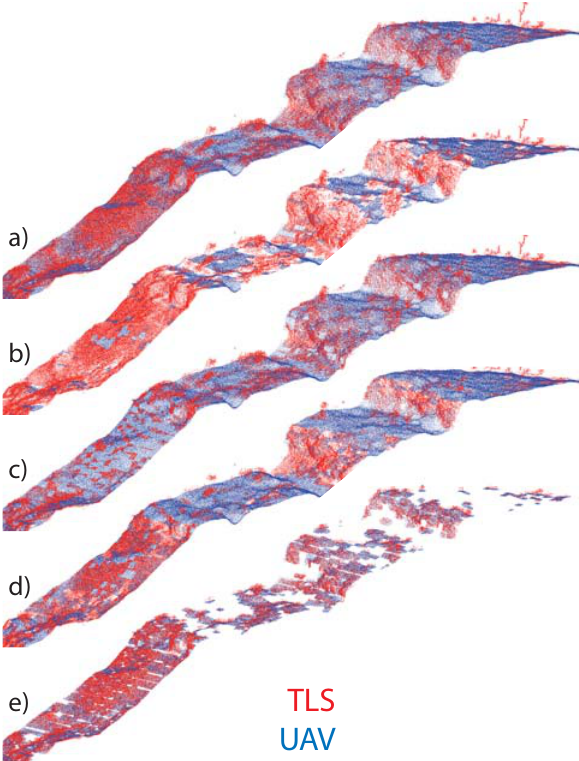
Figure 11. Point cloud profile of the data acquired in 2016 (3m wide; location indicated in Fig. 9) showing examples of the merged point cloud (a) and results after applying the integration rules ’maximum geometric curvature’ (b), ’maximum planarity’ (c), ’minimum elevation’ (d) and ’sensor correspondence’ (e).